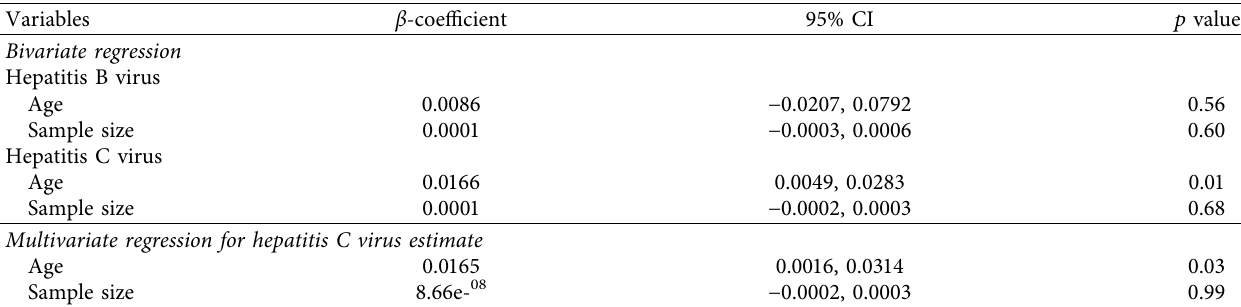
Table 5: Bivariate and multivariate meta-regression analysis of factors associated with the heterogeneity of the three most commonly reported chronic liver disease etiology estimates among chronic liver disease patients in Ethiopia, 2021.